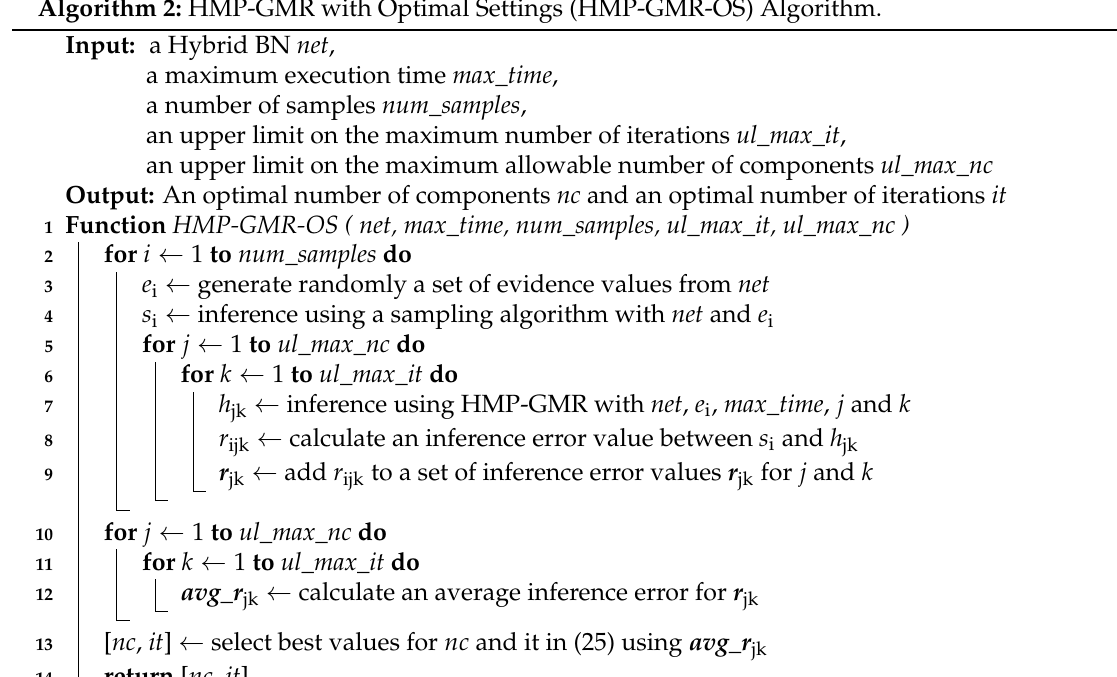
Algorithm 2: HMP-GMR with Optimal Settings (HMP-GMR-OS)